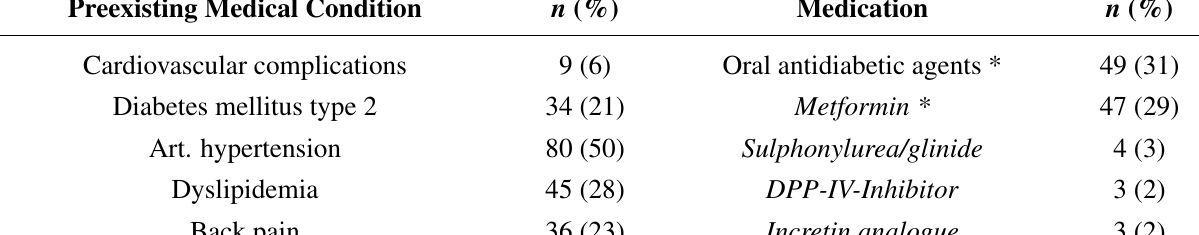
Table 1. Preexisting medical condition and medication at baseline ( n = 160). Preexisting Medical